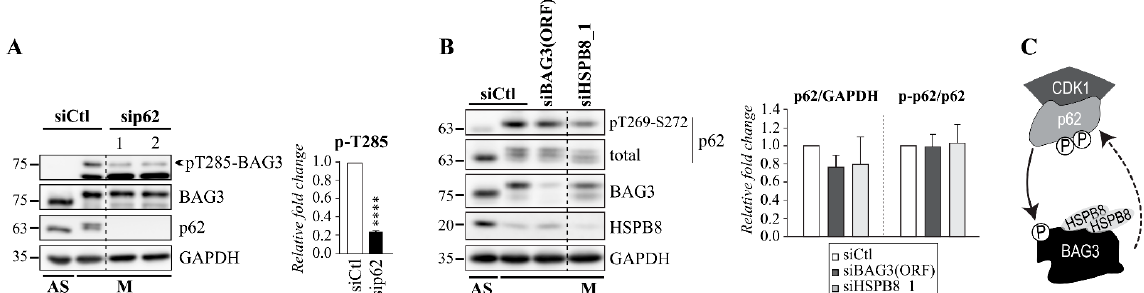
Figure 4. BAG3 phosphorylation at T285 is regulated by p62 during mitosis. ( A ) Western blots of extracts from asynchronous (AS) or mitotic HeLa cells (M) synchronized in mitosis by nocodazole and collected by mitotic shake-off. Cells were transfected with control siRNA (siCtl) or p62-specific siRNAs (sip62) and levels of pT285-BAG3, BAG3, p62, and GAPDH (loading control) are shown. Graph depicting the fold change in pT285-BAG3 levels, as estimated relative to cells transfected with control siRNA and normalized relative to GAPDH levels; means ± SE from 3 independent experiments. Statistical significance was analyzed by the Student (cid:48) s t -Test ****: p < 0.0001. See also Figure S4B that depicts the fold change in BAG3 total levels as estimated relative to cells transfected with control siRNA and normalized relative to GAPDH levels. ( B ) Western blots of cell extracts prepared from asynchronous (AS) or from mitotic HeLa cells (M) synchronized in mitosis by nocodazole and collected by mitotic shake-off; cells were transfected with control siRNA (siCtl) or BAG3-specific siRNA (siBAG3 [ORF]) or HSPB8-specific siRNAs, and protein levels are shown as indicated. Graphs depicting the fold change in total p62 levels (p62) normalized relative to GAPDH levels, and the fold change in pT269-S272-p62 levels (p-p62) normalized relative p62 total levels, as estimated relative to cells transfected with control siRNA. Data are means ± SE from 3 independent experiments. ( C ) Scheme recapitulating putative functional relationships: CDK1 phosphorylates p62 that in turn enhances CDK1 activity [59]; the increased mitotic association between the BAG3-HSPB8 chaperone complex and p62 may promote BAG3 phosphorylation and stabilize p62 during